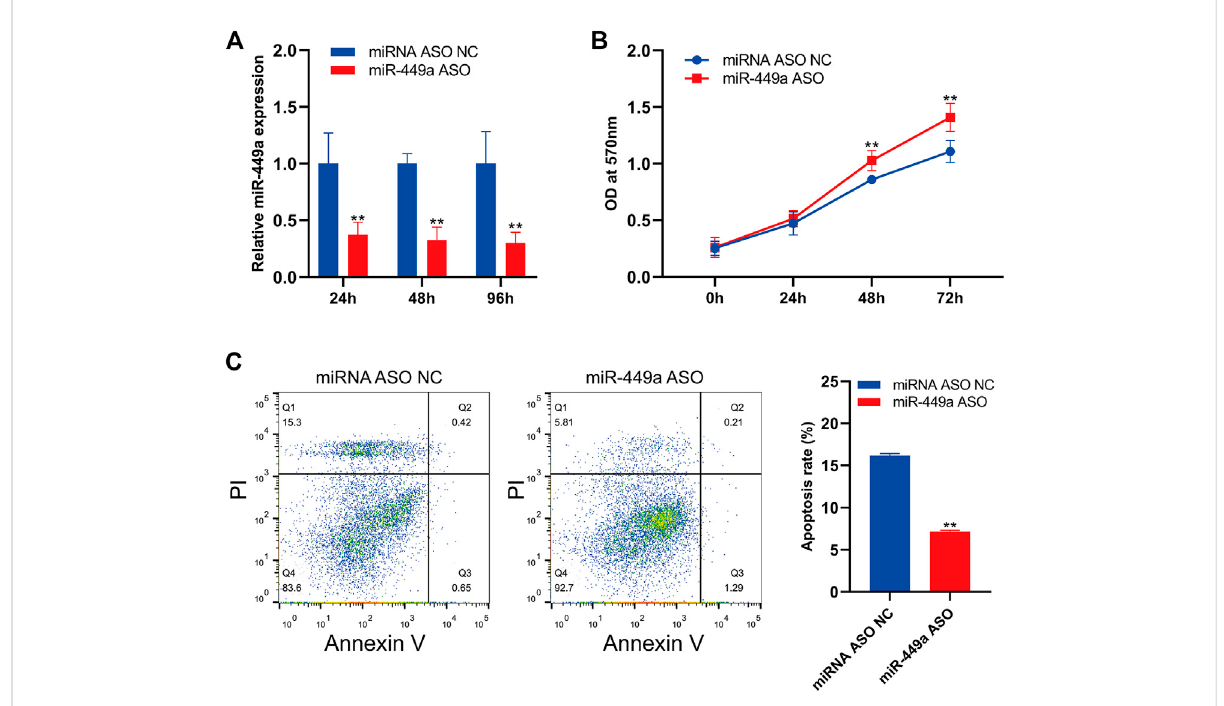
FIGURE 9 Inhibition of miR-449a promotes SaOS-2 cell proliferation and inhibits apoptosis. (A) SaOS-2 cells were transfected with miR-449a ASOs. (B) Following transfection, cell proliferation was analyzed by MTT assay. (C) Annexin V/PI double staining was performed 24 h after transfection with miR-449a ASO to analyze apoptosis